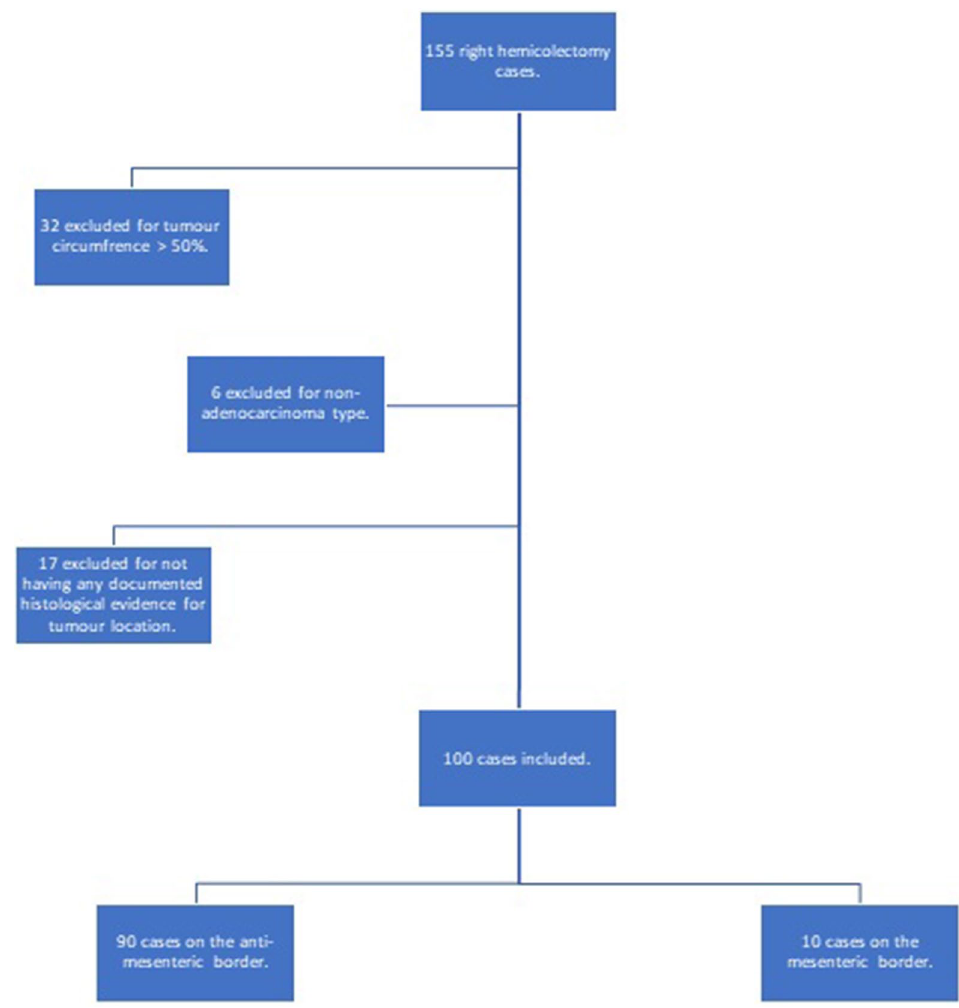
Figure 2. Study inclusion and exclusion criteria flowsheet.